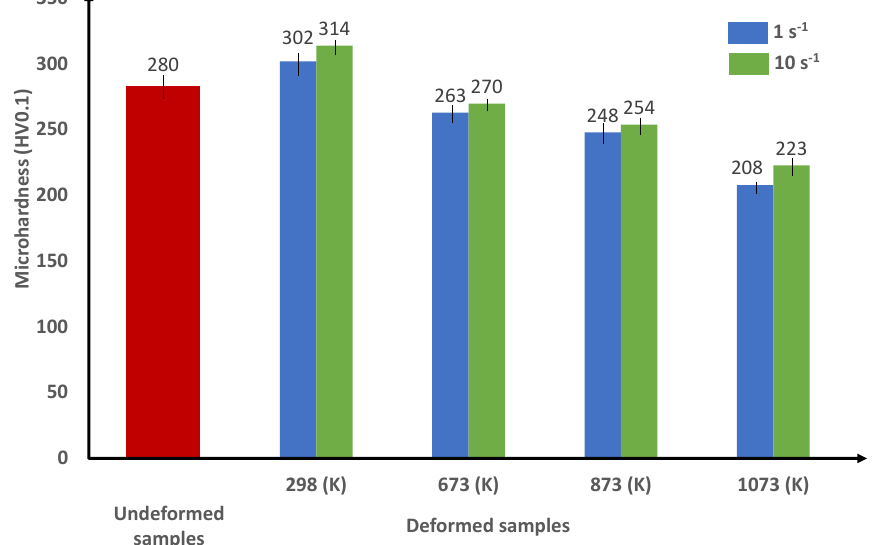
Figure 9. Vickers microhardness of the un-deformed and the deformed Ti42Nb alloy produced by LB-PBF with BD-90 ◦ at different temperatures and strain